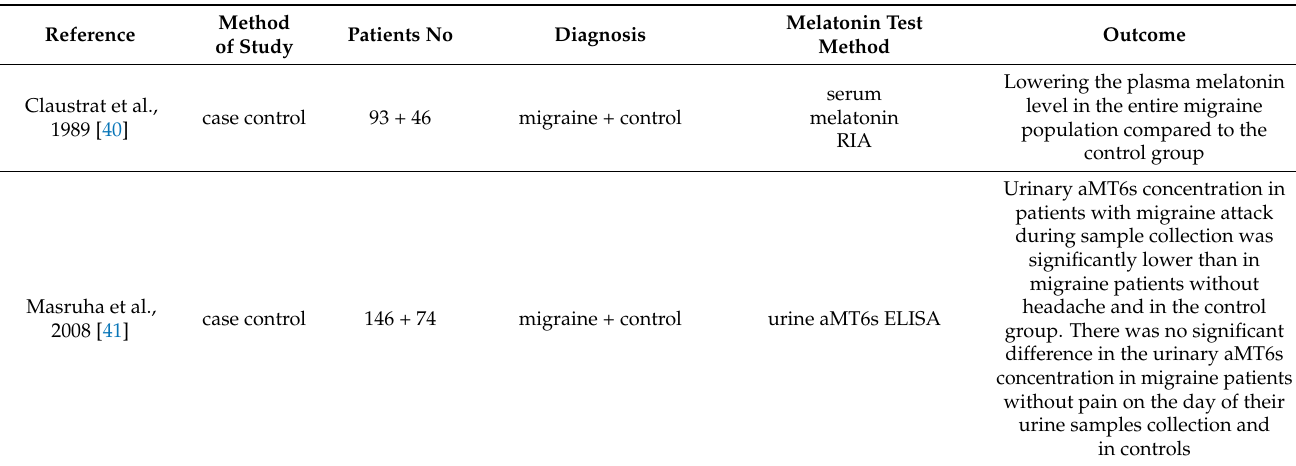
Table 1. Studies investigating the relationship between melatonin levels and